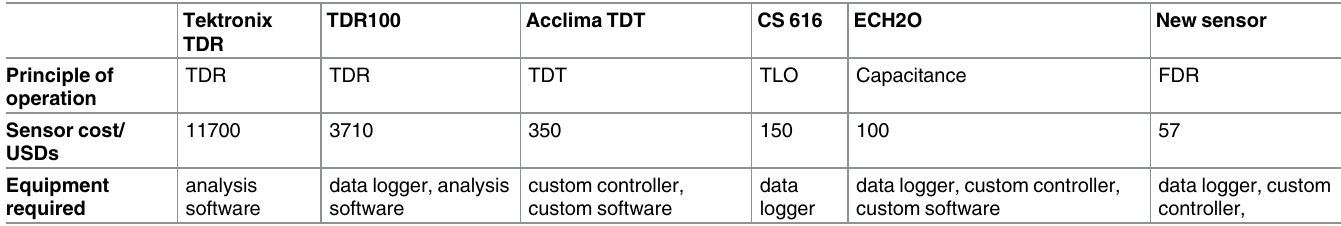
Table 2. Comparison with other existing sensors.